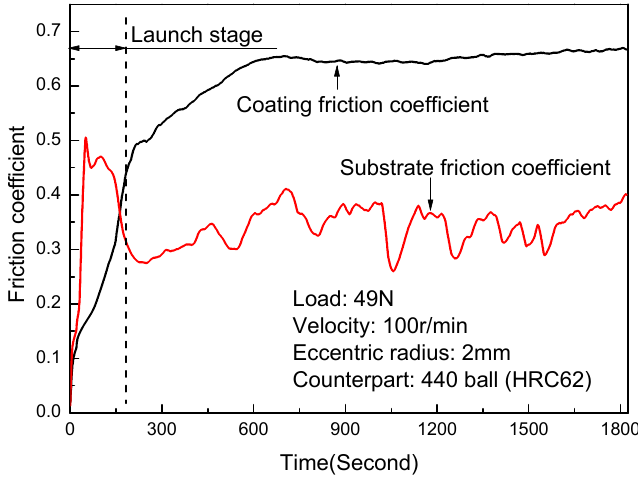
Figure 9. Friction coefficient curves of the coating and the substrate.